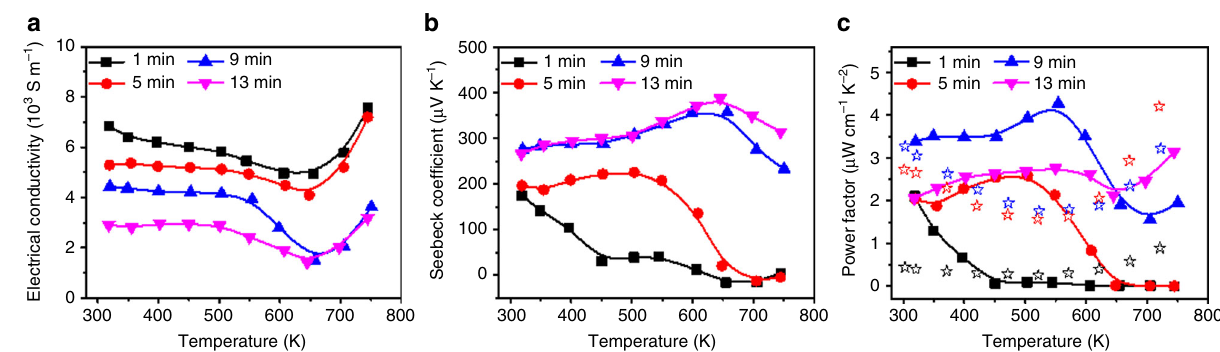
Fig. 6 Temperature-dependent TE properties of SnSe thin fi lms. a – c Graphs show electrical conductivities ( a ), Seebeck coef fi cients ( b ), and power factors ( c ) for SnSe thin fi lms annealed at 400°C for 1, 5, 9, and 13 min. Stars in c indicate data points obtained with SnSe single crystals in a (black), b (red), and